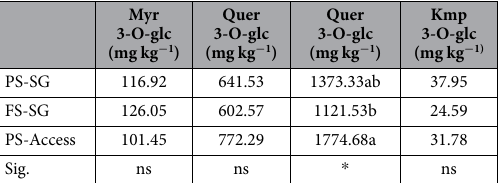
Table 7. Flavonols composition at harvest of berry skins of SG (susceptible clone R10) and accession 72-096 (resistant). PF = partially sprayed. FS = fully sprayed. Data are given as mg/kg of skin dry weight. Abbreviations: Myr: myricetin, Quer: quercetin, Kmp: kaempferol, gluc: glucuronide, glc: glucoside. * Denote significant differences between treatments at P < 0.05 according to within column mean separation performed with SNK test and showed by small letters. ns = not significant.